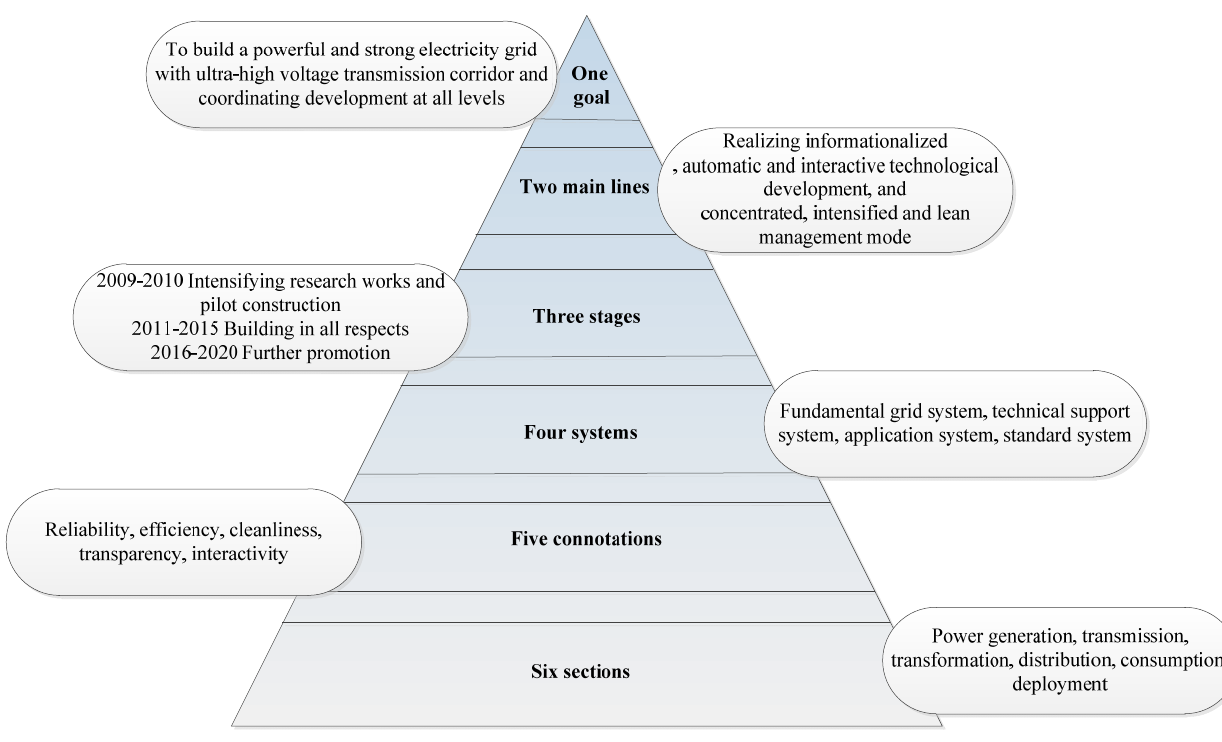
Figure 2. The strategic framework of strong smart grid